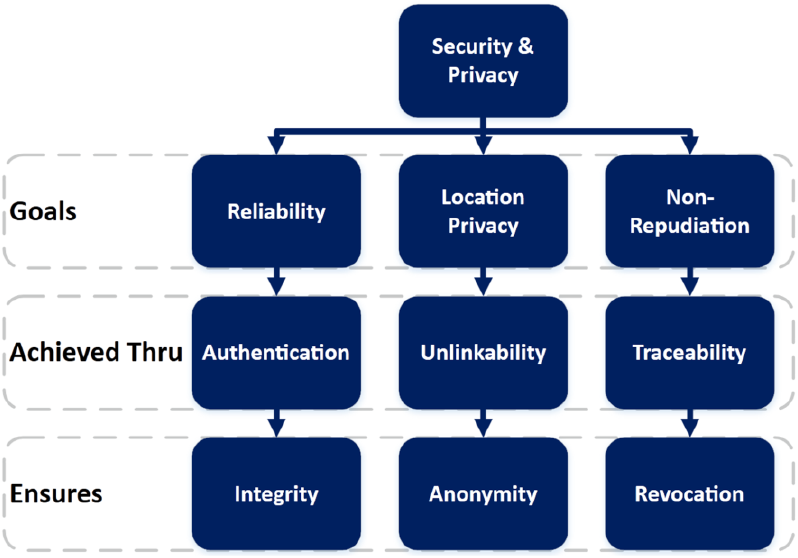
Figure 4. Security and privacy goals in VANETs and how they are